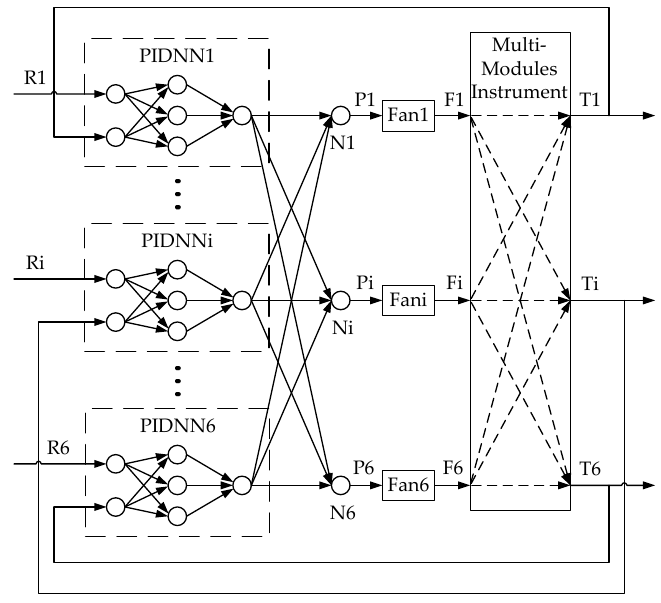
Figure 1. Structure of the fully-connected proportional–integral–derivative neural network (FCPIDNN) temperature controller for an instrument.